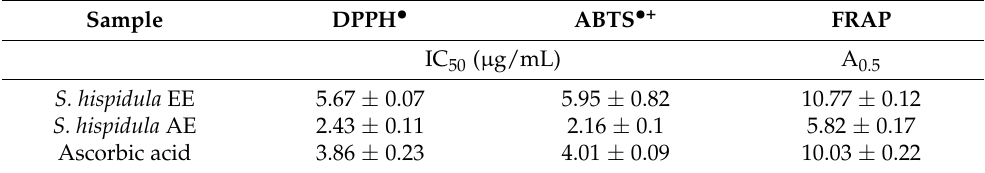
Table 3. Antioxidant activity of S. hispidula extracts by DPPH • , ABTS • + , and FRAP assays.